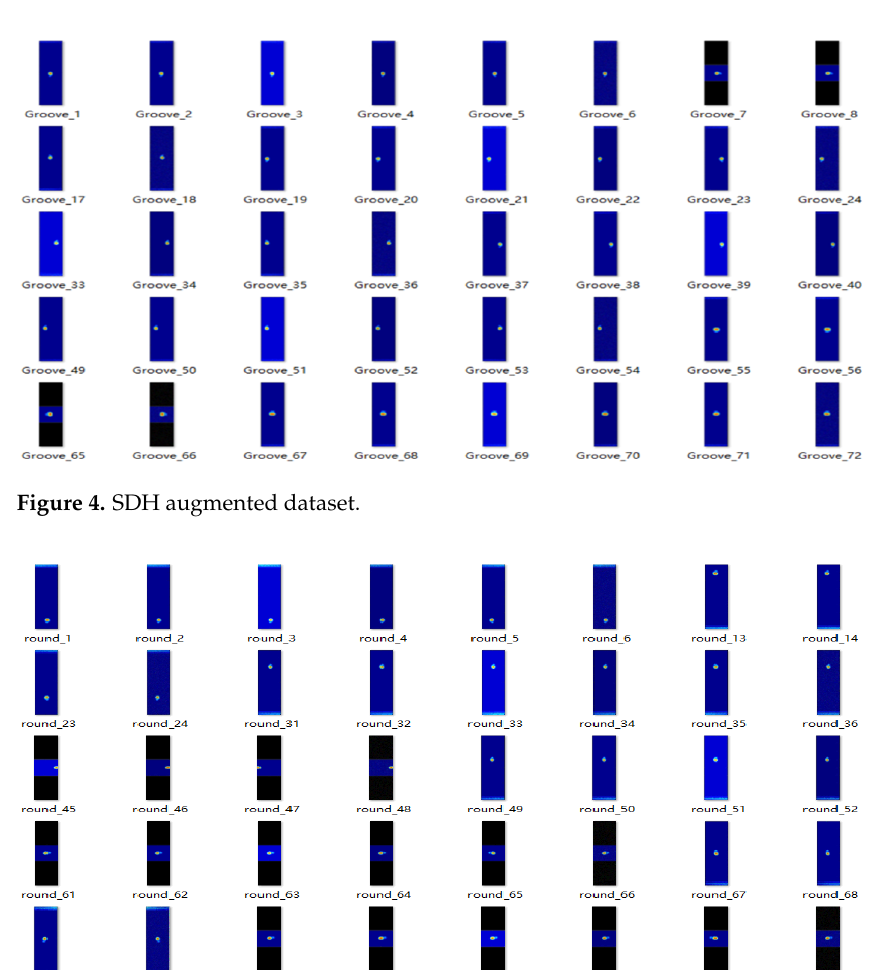
Figure 3. Augmented dataset.